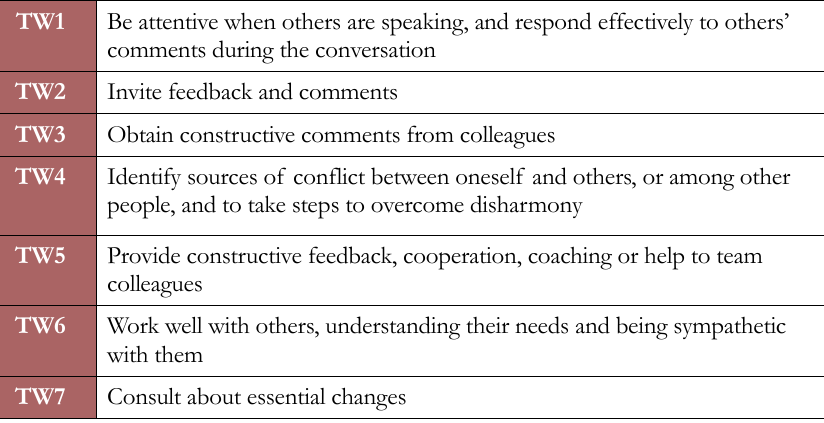
Table 9. Behavioral indicators in the FINCODA Team work dimension